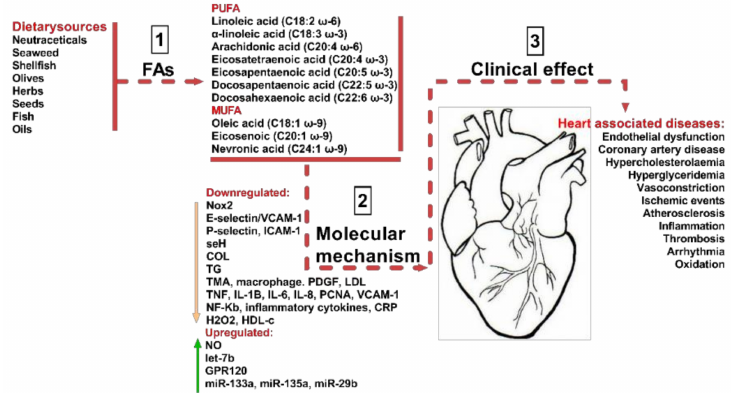
Figure 1. Sources of beneficial MUFA and PUFA and their impact on CVDs. As indicated in step (1) the most common dietary sources are neutraceticals, seaweed, shellfish, olives, herbs, seeds, fish, and various oils. They provide various polyunsaturated fatty acids (PUFA) including linoleic acid, arachidonic acid, eicosatetraenoic acid, eicosapentaenoic acid, docosapentaeinoic acid, and docosahexaenoic acid. Dietary sources also provide monounsaturated fatty acids (MUFA) including ω -9 oleic acid, eicosenoicacid, and nevronic acid. By various molecular mechanisms (2), they have a beneficial impact on CVD clinical effects, as described in step (3). The molecular mechanisms are Nox2-NADPH oxidase 2, E-selectin-leukocyte endothelial adhesion molecule, cell adhesion molecule, seH-lipid signaling molecule, COL-collagen factor, TG-triglycerides, TMA-thrombotic microangiopath, PDGF-platelet derived growth factor, LDL-low density lipoprotein, TNF-tumor necrosis factor, IL8, 6 and 1B-interleukins, PCNA-proliferating cell nuclear antigen, VCAM1-vascular cell adhesion protein 1, NF-Kb-nuclear factor kappa light chain enhancer of activated B cells, CRP-C reactive protein, H2O2-hydrogen peroxide, HDL-high density lipoprotein, NO-nitric oxide, let-7b- tumor suppressor miRNA, ω -3 fatty acid receptor, miR-133a, miR-135a, and miR-29b-non-coding RNAs important in cardiac muscle